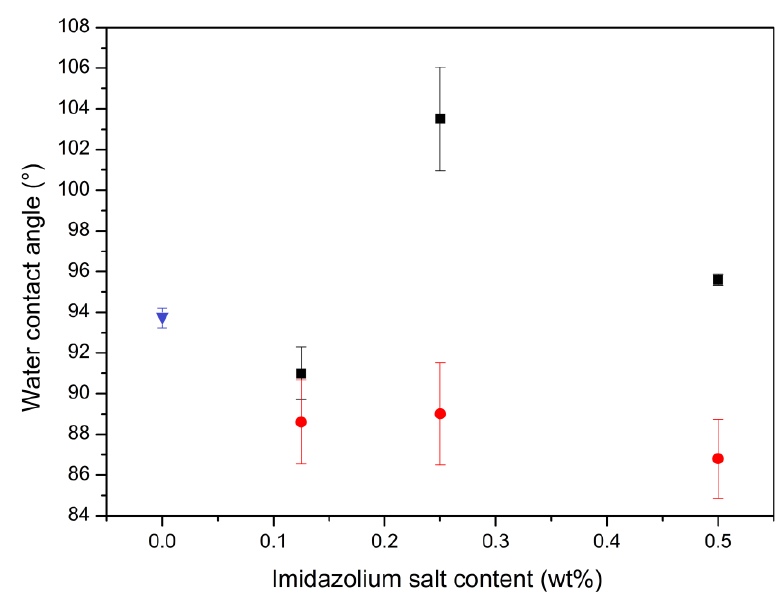
Figure 5. Water contact angles for HDPE films related to the IS content: HDPE (blue ▼ ), HDPE.Cl (black ◼ ), and HDPE.MeS (red ⬤ ).